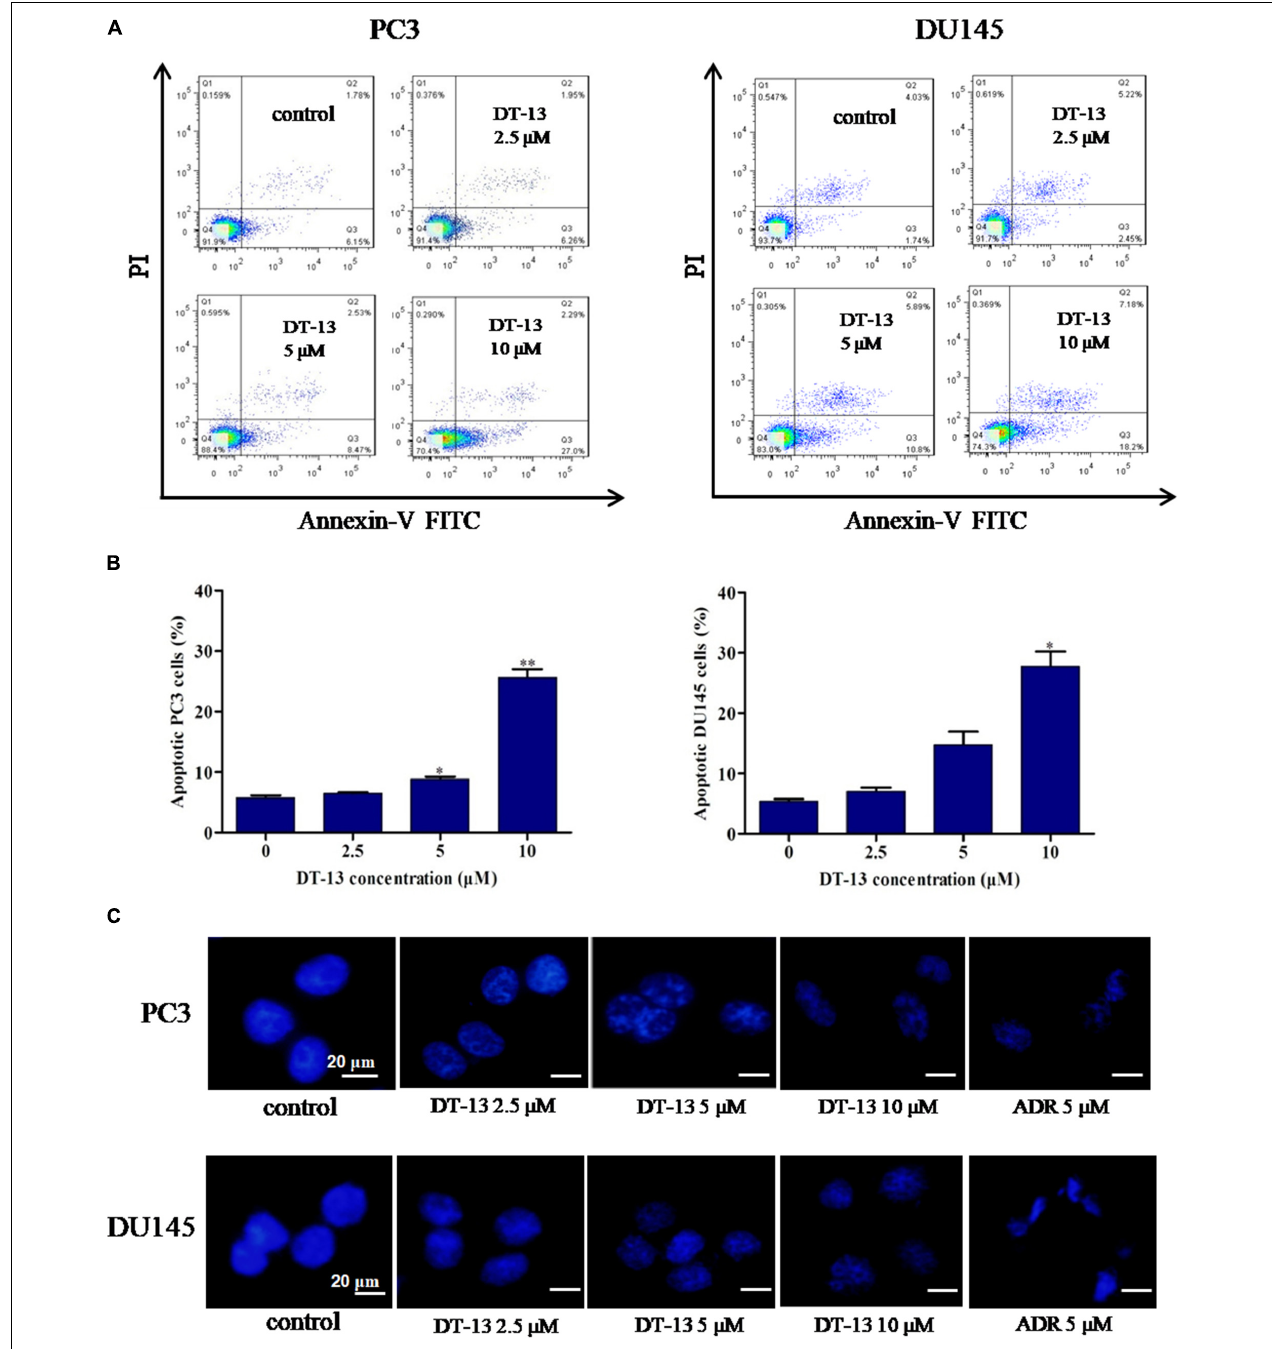
FIGURE 3 | DT-13 induced apoptosis in prostate cancer cells. (A) PC3 and DU145 cells were treated with DT-13 at 0, 2.5, 5, and 10 µ M for 48 h, stained with AnnexinV-FITC and PI, and then measured by flow cytometer. (B) The histograms show the percentage of apoptotic cells in PC3 and DU145 cells treated with indicated concentrations of DT-13 for 24 h. Data are mean ± SD ( n = 3), representative of three independent experiments. ∗ P < 0.05, ∗∗ P < 0.01, compared with control. (C) PC3 and DU145 cells treated with different concentrations of DT-13 or 5 µ M Adriamycin (ADR) for 48 h, followed by staining with Hoechst 33342. Cytoplasmic shrinkage and nuclear fragmentation were observed under the fluorescence microscopy. Scale bar = 20 µ m.